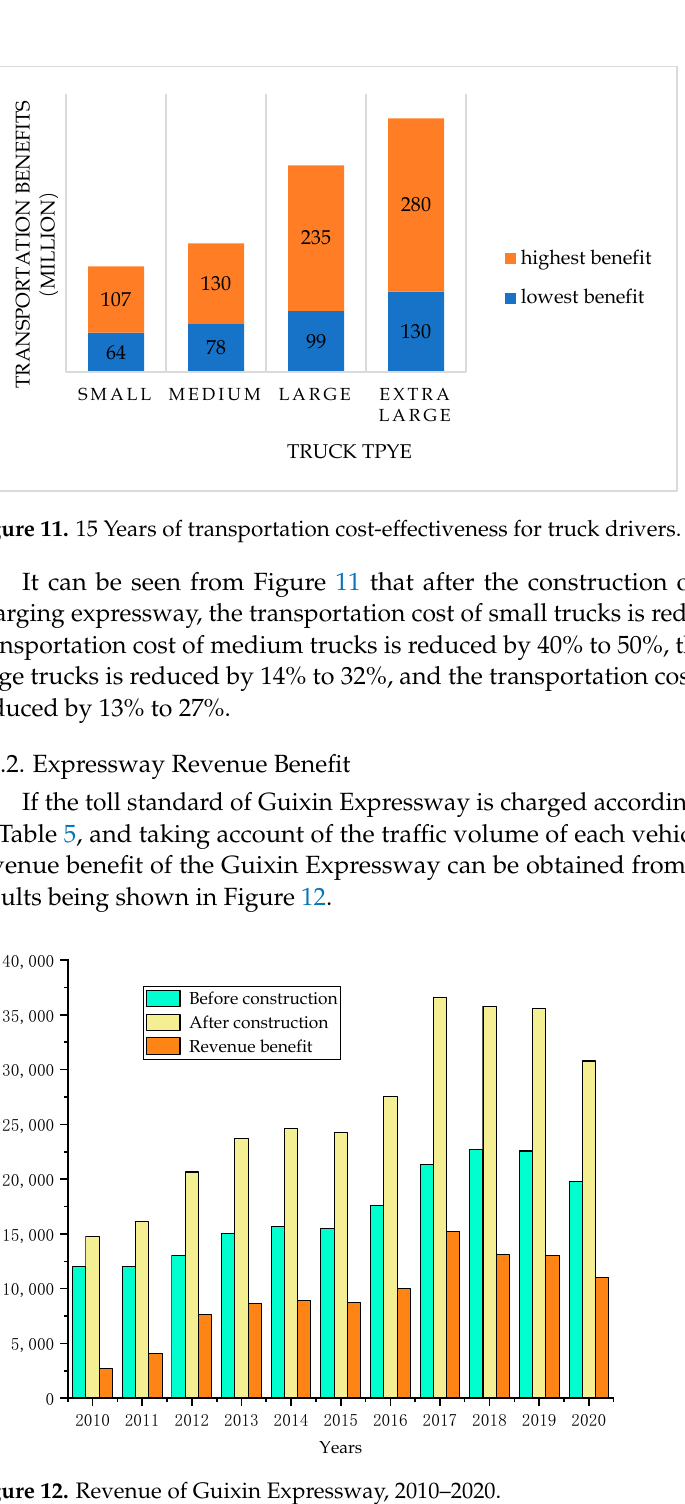
Figure 12. Revenue of Guixin Expressway, 2010–2020.